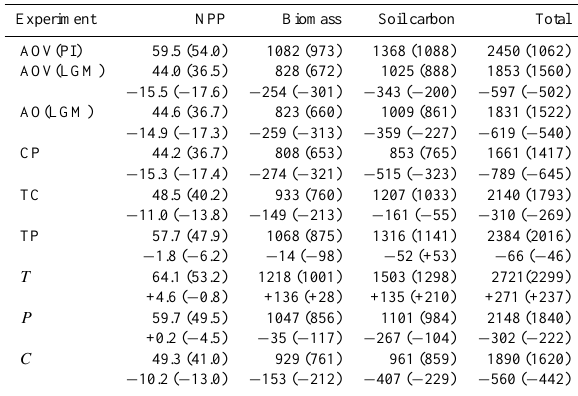
Table 3. Equilibrium global NPP (PgCyr − 1 ) and global biomass, soil carbon and total carbon storage (PgC). The sum of four biomass carbon pools is shown as “biomass”. The sum of three soil carbon pools is shown as “soil carbon”. Total carbon is sum of biomass and soil carbon. Values in the parentheses do not include the LGM ice- sheet area in the preindustrial nor continental shelf area in the LGM to extract pure response to climate and atmospheric CO 2 . Result of AOV(PI) and upper column of other experiments are absolute values. In lower columns, values denote absolute differences with respect to AOV(PI). The last digit can include a rounding